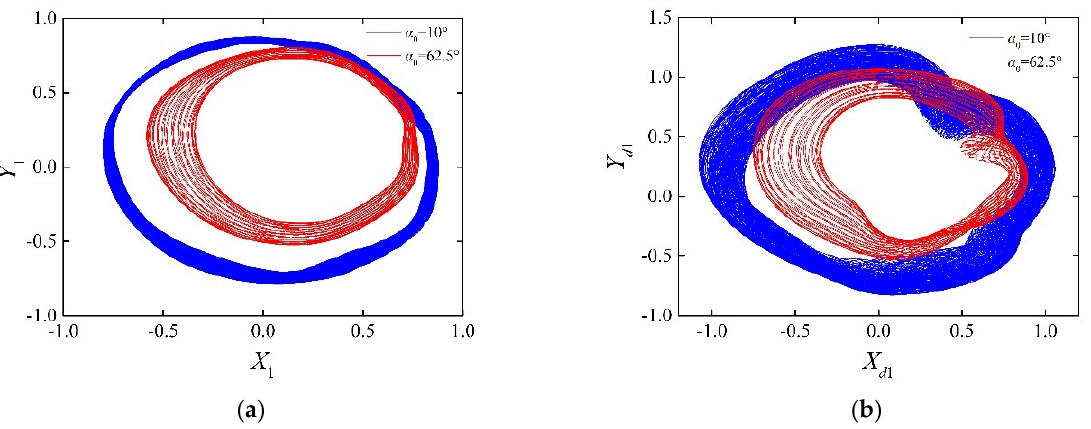
Figure 12. When ω = 2500 rad/s, comparison of the rod–fastened rotor at α 0 = 10°, 62.5°: ( a ) comparison of the orbits at the left bearing station; ( b ) comparison of the orbits at the left disk station.